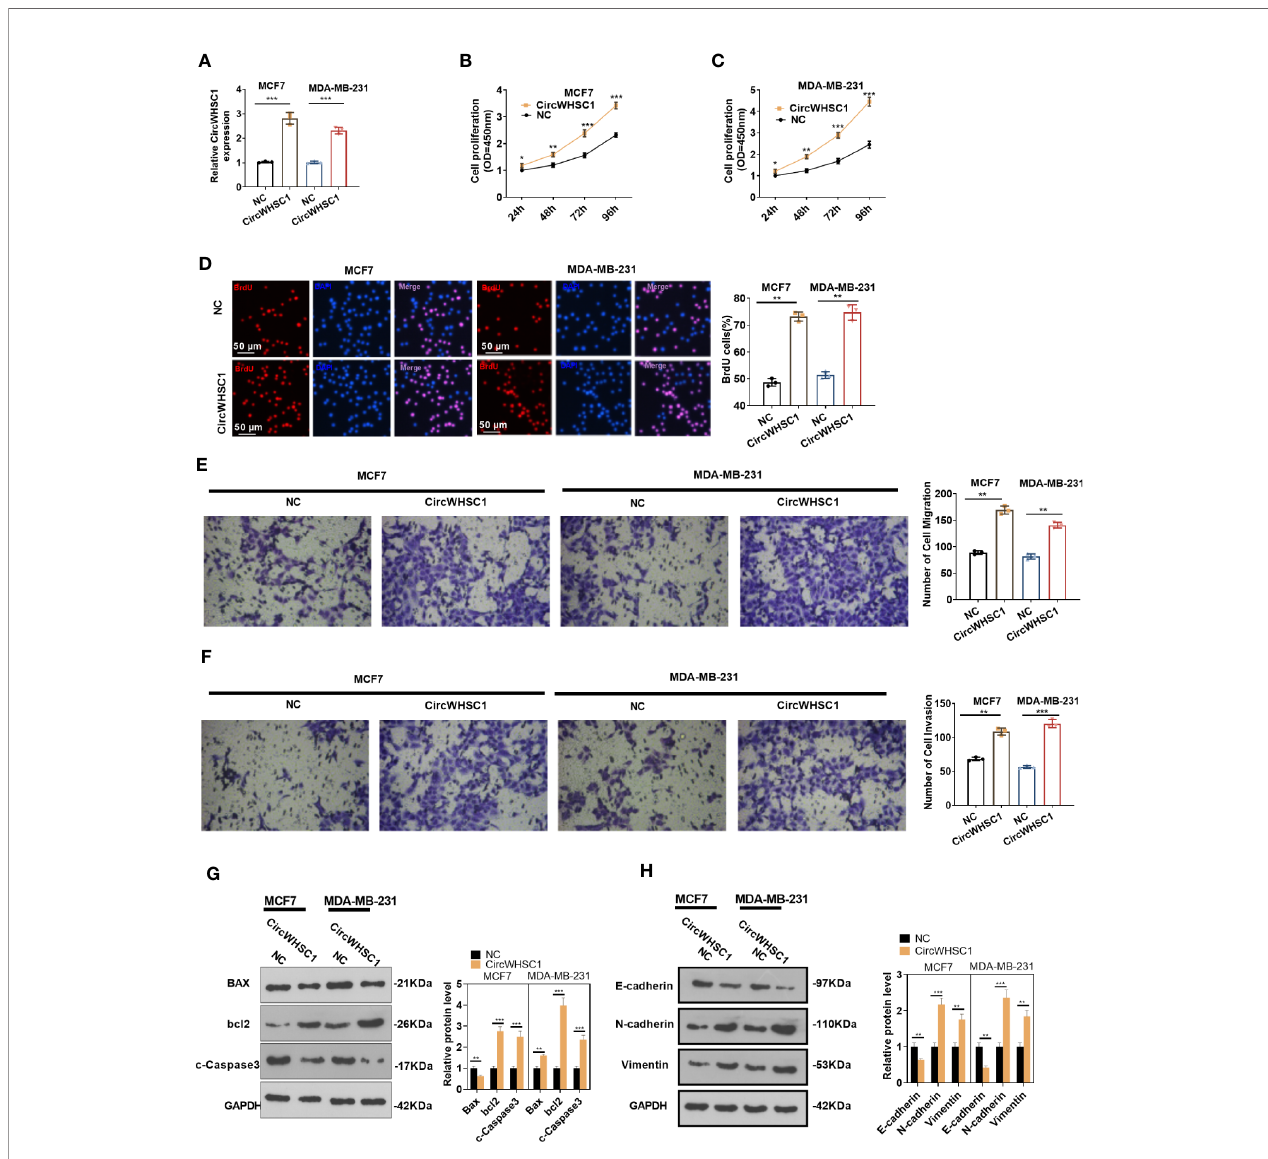
FIGURE 2 | CircWHSC1 affected BC cell proliferation, migration and invasion. (A) CircWHSC1 overexpression models were set up in MCF7 and MDA-MB-231, respectively. (B – D) CCK-8 (B, C) and BrdU assay (D) detected cell viability and proliferation, * P < 0.05, ** P < 0.01, *** P < 0.001 vs. NC group. scale bar=50 m m. (E, F) The effect of CircWHSC1 overexpression on cell migration and invasion was testi fi ed by the transwell assay. (G, H) . WB was performed for evaluating the protein levels of Bax, bcl2, c-Caspase3, E-cadherin, N-cadherin, and Vimentin. * P < 0.05, ** P < 0.01, *** P < 0.001.